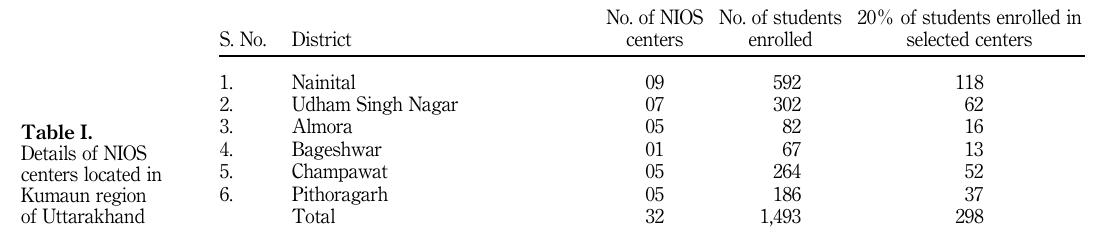
centers located in Kumaun region of